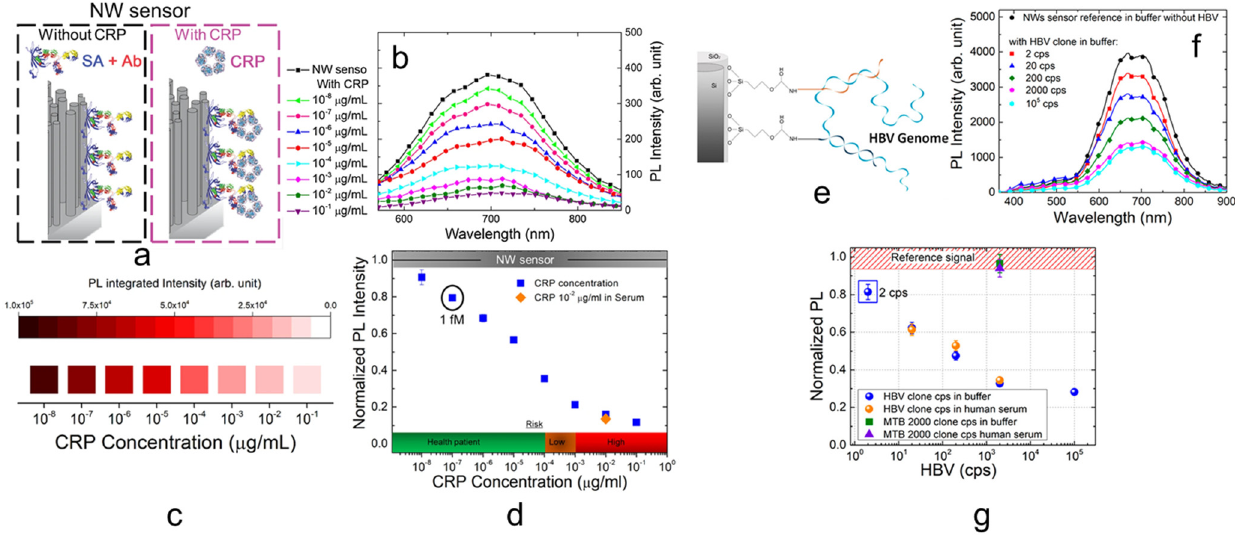
Figure 4. ( a ) Si NW sensor functionalization for the detection of CRP [103]. ( b ) PL spectra as a function of different CRP concentrations. ( c ) Schematic representation of the Si NW quenching (sensing mechanism) as a function of the CRP concentration. ( d ) Dose-response curve obtained as the PL signal of the sensor normalized to the reference signal (obtained without CRP) as a function of the CRP concentration. ( e ) Si NW sensor functionalization for HBV detection [102]. ( f ) PL spectra of the Si NW sensor tested with different copies of HBV in buffer. ( g ) Dose-response curve obtained as the PL signal of the sensor normalized to the reference signal (obtained without HBV) as a function of the HBV copies in 100 μ L of buffer (blue points) or human serum (orange points) [102]. ( a – d ) are reproduced with permission [98], Copyright 2018, Springer. ( e – g ) are reproduced with permission [102], Copyright 2018, American Chemical Society.